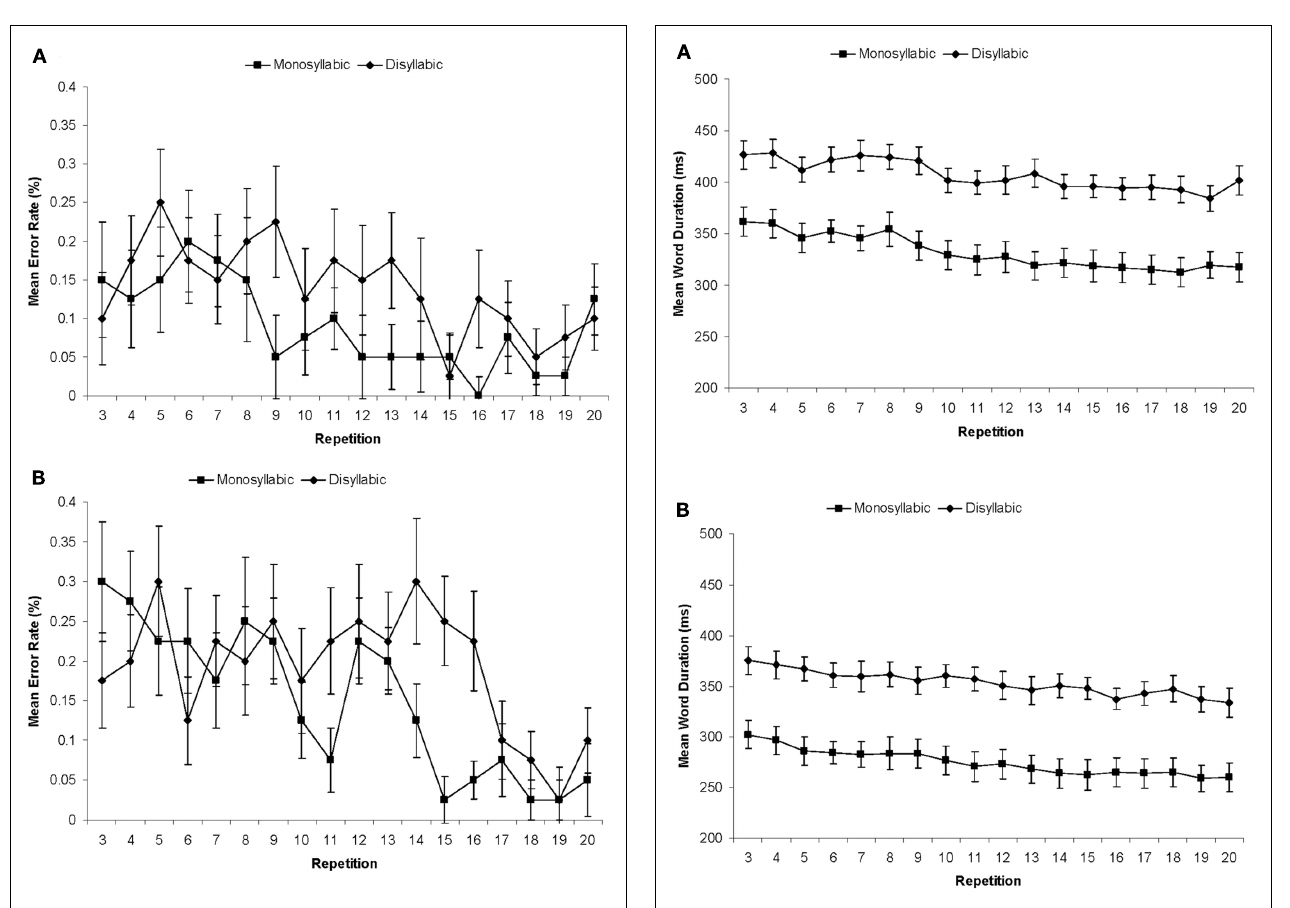
FIGURE 7 | Results of Experiment 2. Mean word durations (ms) for monosyllabic and disyllabic items on repetitions 3 through 20 in the Moderate Pace Group (A) and the Fast Pace Group (B)